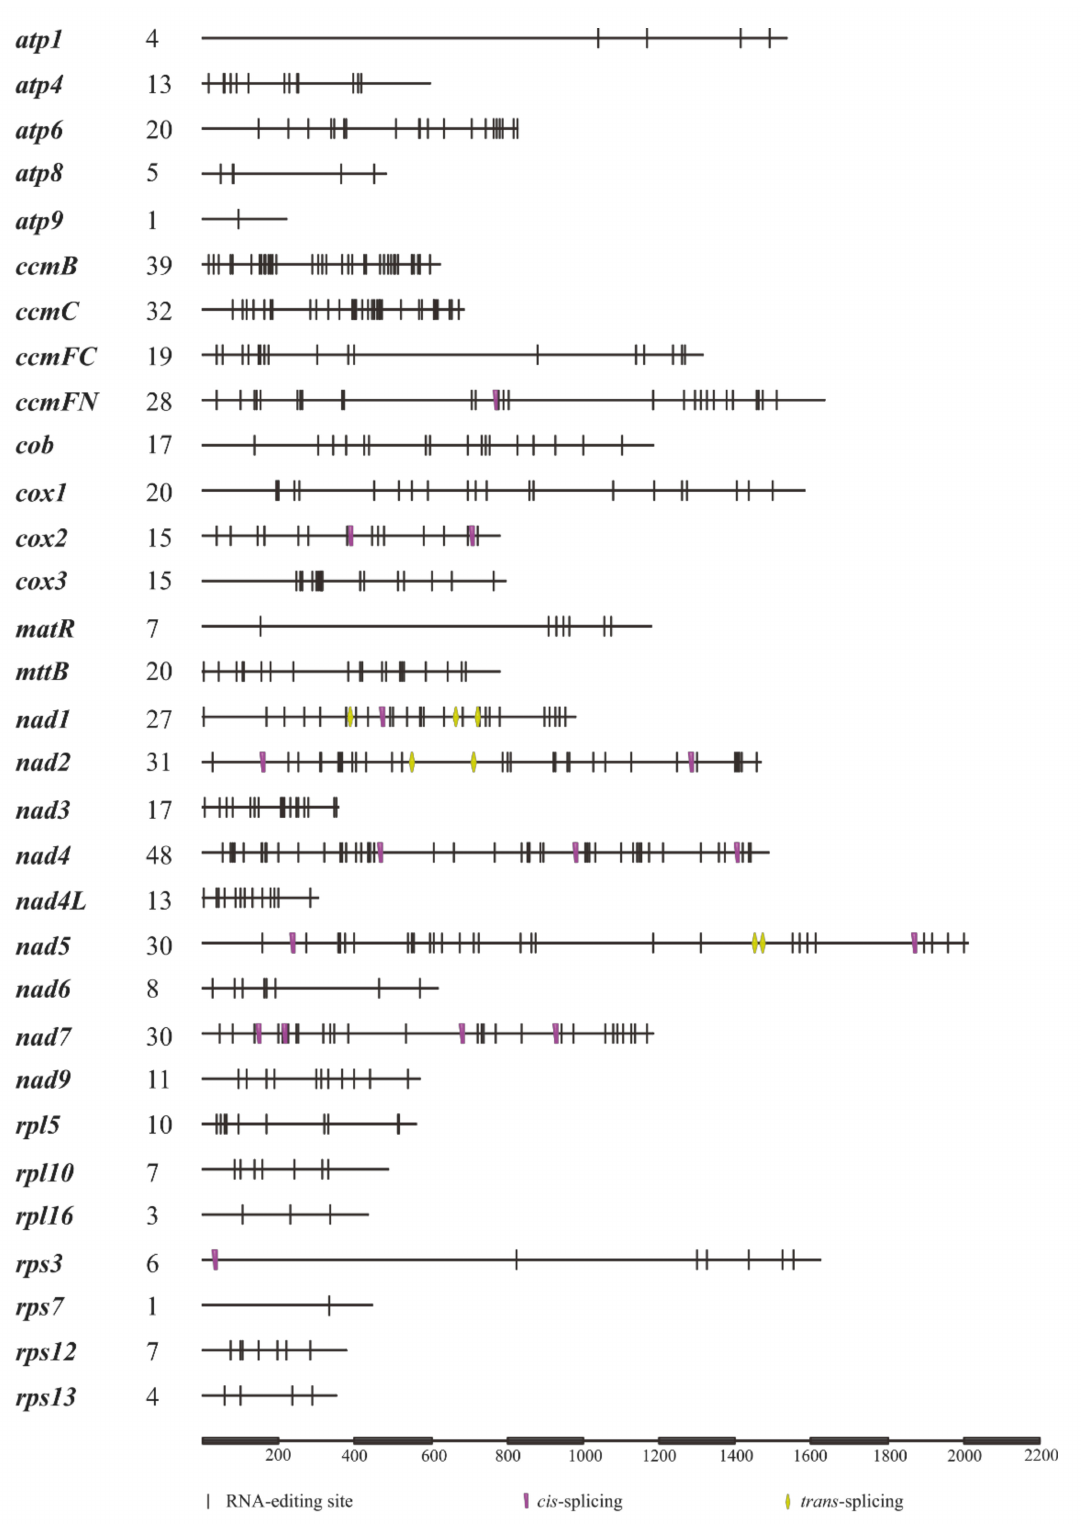
Figure 3. Localization of RNA editing sites in mitochondrial PCGs within S. plumbizincicola